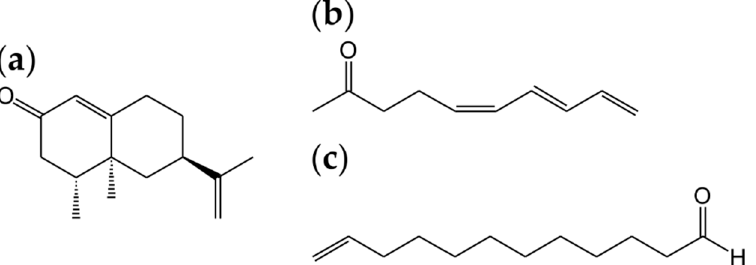
cetes. ( a ) (+) ‐ Nootkatone, the character impact compound of grapefruit; ( b ) (5 Z ,7 E ,9) ‐ decatriene ‐ 2 ‐ iomycetes. ( a ) (+)-Nootkatone, the character impact compound of grapefruit; ( b ) (5 Z ,7 E one, volatile with a very strong pineapple flavour; ( c ) dodec ‐ 11 ‐ enal, a flavour with a coriander/leaf ‐